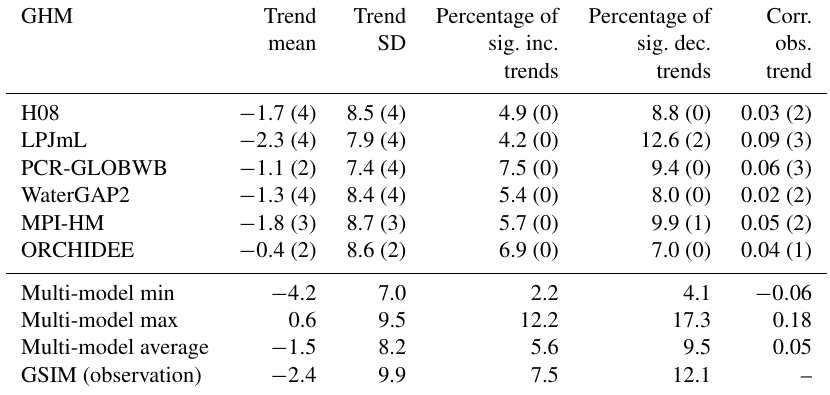
Table 4. Characteristics of trends in the MAX7 index over the 1971–2005 period across 3666 locations for GCMHIND simulated trends. Trend mean and trend standard deviation are expressed in percentage change per decade. Intra-model averages of trend characteristics are shown for each GHM. Values in the parentheses show the number of simulations rejecting the null hypothesis (from 1 to 4) outlined in Table 2 (out of four GCMs). Multi-model minimum, maximum, and average values together with those exhibited from GSIM are also provided. GHM Trend Trend Percentage of Percentage of Corr. mean SD sig. inc. sig. dec. obs. trends trends trend H08 − 1 . 7 (4) 8.5 (4) 4.9 (0) 8.8 (0) 0.03 (2) LPJmL